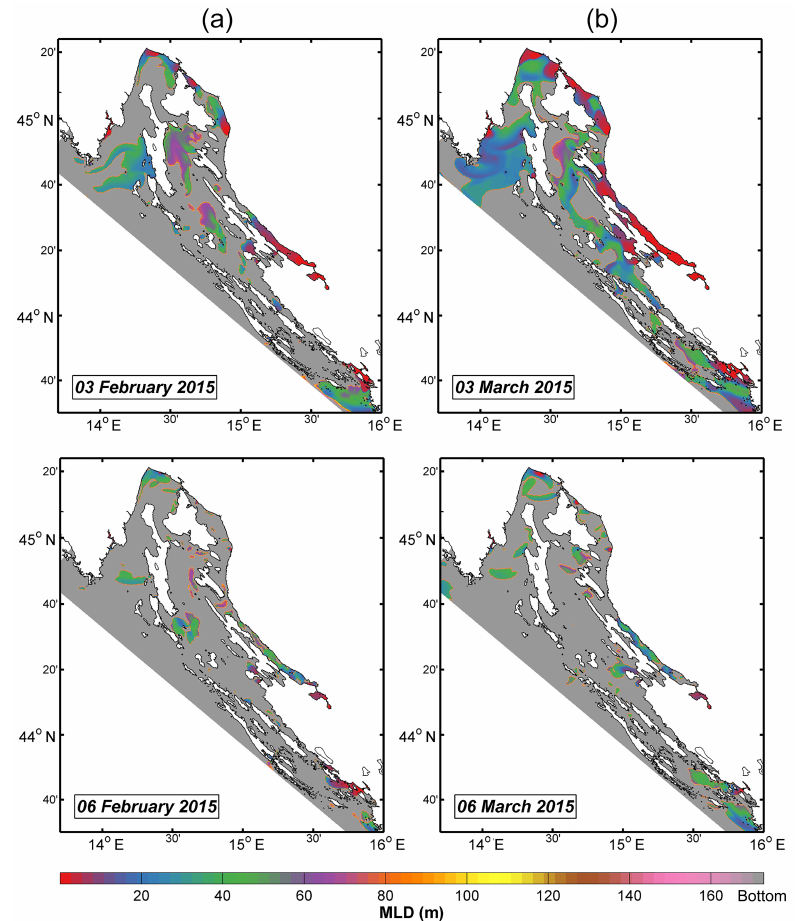
Figure 11. Mixed-layer depth (MLD) computed for the nested model domain prior and after the major bora episodes: 3 and 6 February 2015 (left column) and 3 and 6 March 2015 (right column). Grey stands for MLD reaching the